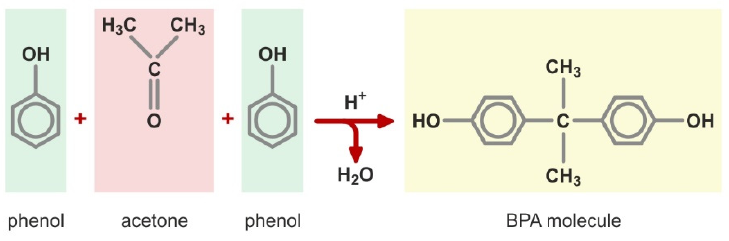
Figure 1. C 15 H 16 O 2 (R-SO 3 H). The synthesis of bisphenol A.